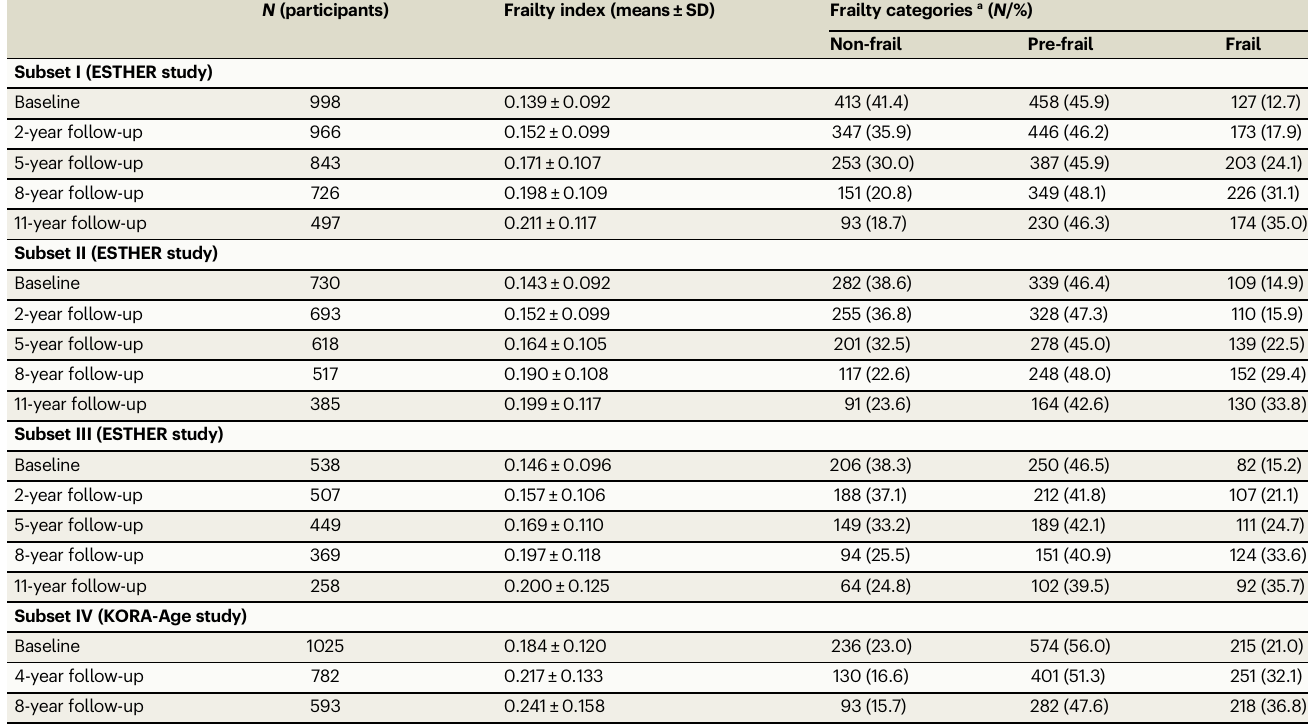
Table 2 | Frailty characteristics by follow-ups and subsets N